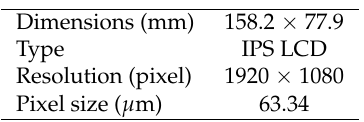
Table 2. Specifications of the LCD